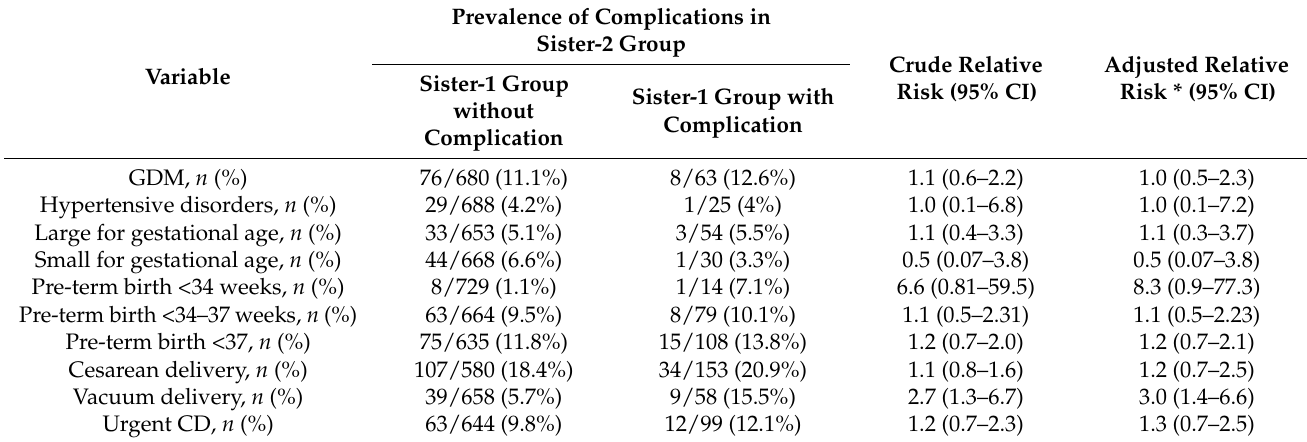
Table 3. Relative risk of pregnancy and delivery outcomes across